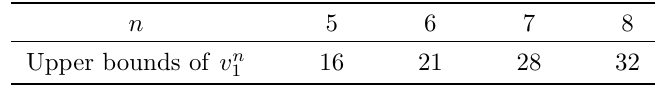
Table 5: The upper bounds of v n